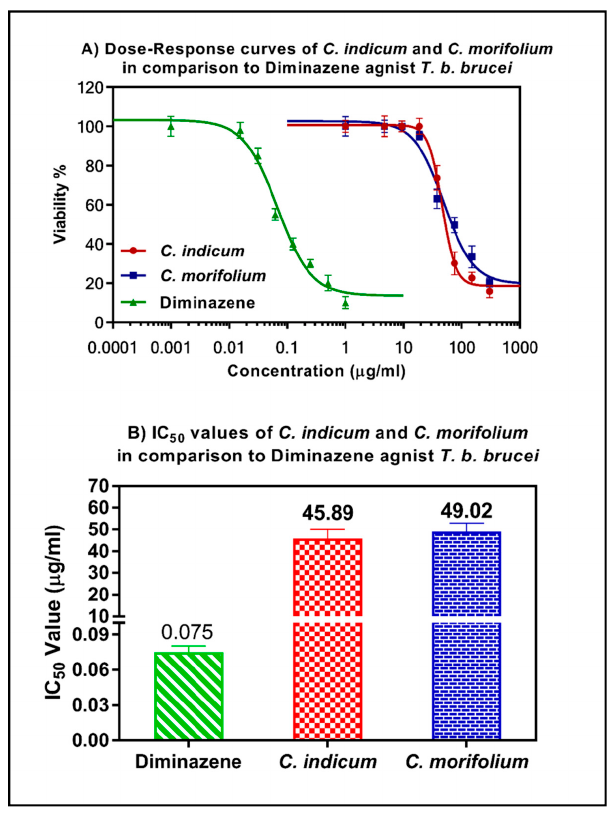
Figure 7. Anti-trypanosomal activity of the essential oils obtained from C. indicum and C. morifolium flower heads versus reference drugs. Foods 2020 , 9 , x FOR PEER REVIEW